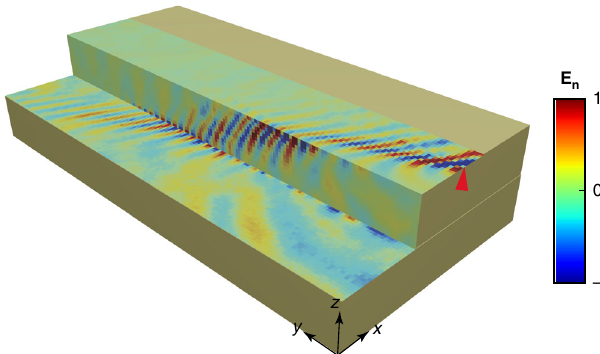
Fig. 5 Topologically protected surface waves propagating on a step. A backscattering-immune surface wave propagates on a three-dimensional step geometry. The source ( red triangle ) is set with x -polarization, whereas the normal component of the electric fi eld is probed for all surfaces. The step width, height, and length are 104 mm (both for upper and lower surfaces), 60 and 600 mm, respectively. The normal electric fi eld is normalized with respect to its maximum value. (See real experimental setup in Supplementary Fig.